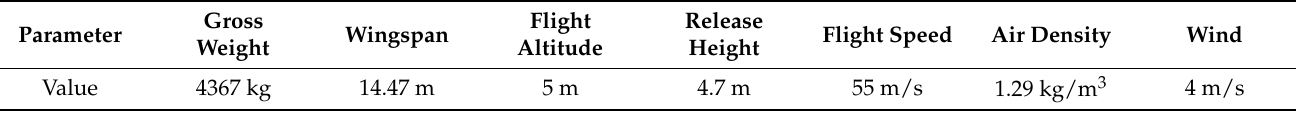
Table 1. The parameters of Thrush 510G aerial